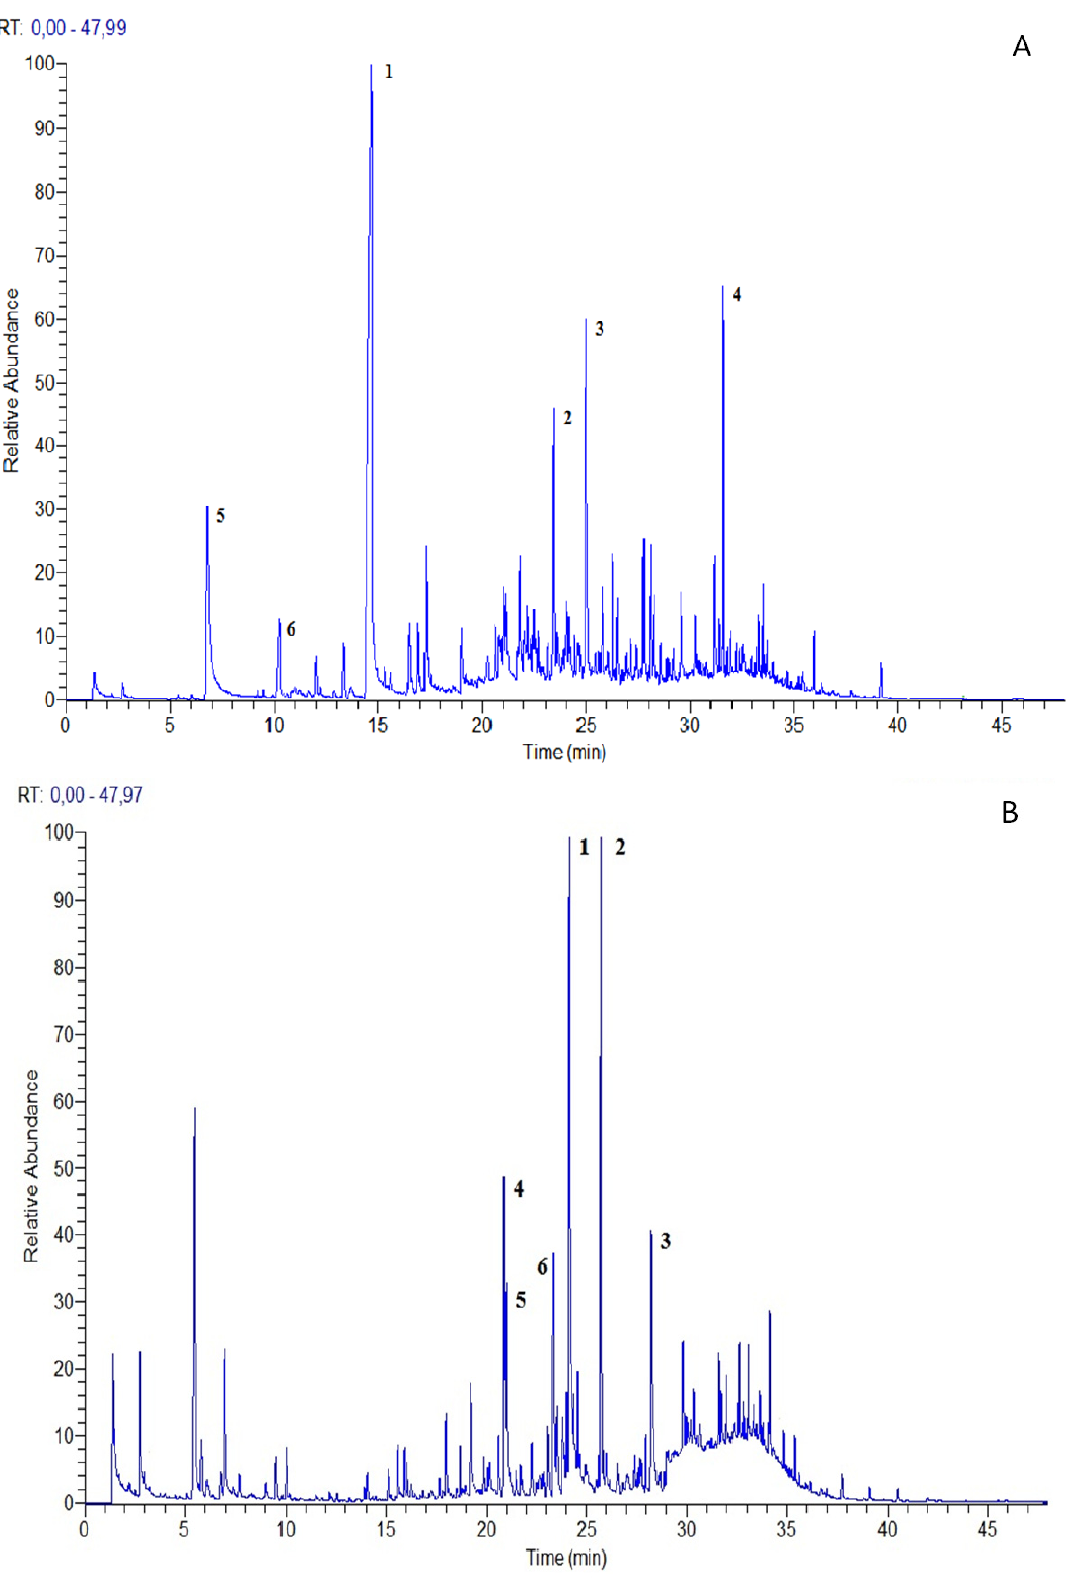
Figure 1. Volatile fingerprint of O. sphegodes subsp. sphegodes ( A ), O. bertolonii subsp. benacensis ( B ) and N . tridentata ( C ) “ in vivo ” plant (the most representative compound peaks were labeled with